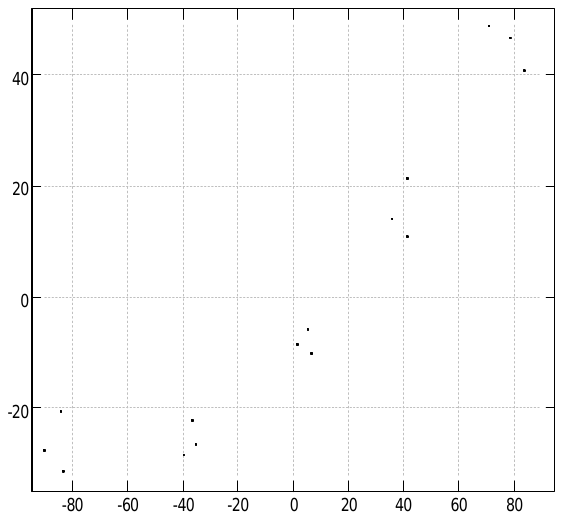
Figure 2 2-dimensional representation of proximity matrix 2 produced by the SMACOF algorithm Visually there are 5 well separated clusters as is also apparent from the proximity matrix. The membership matrices are as in Table 5. Maximum values have been bolded. Table 5 Membership matrices produced by the various clustering methods for proximity matrix 2. Membership values have been multiplied by 100, to reduce space. The symbol * represents the value 100 O FRFP NERFCM Rouben Winham